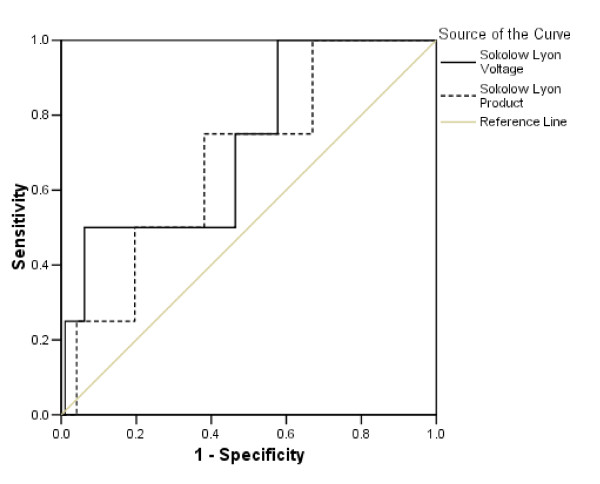
ROC curves with a cut off value of 108 g/m2 for LV hypertrophy.